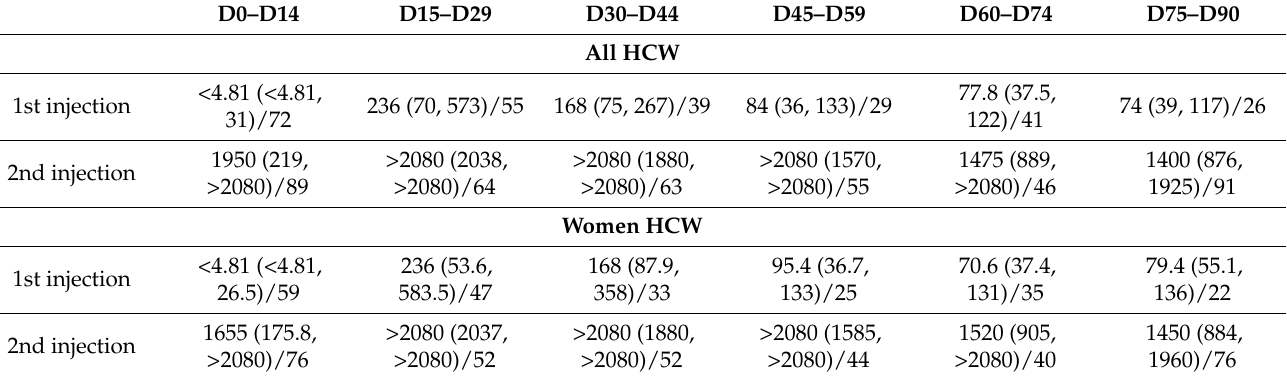
Table 3. Results of antibody response following vaccination in Health Care Workers: titer of neutral- izing antibodies expressed as median (25th, 75th percentiles) (in BAU/mL) according to participant characteristics (at baseline) and date of sample collection regarding the vaccine